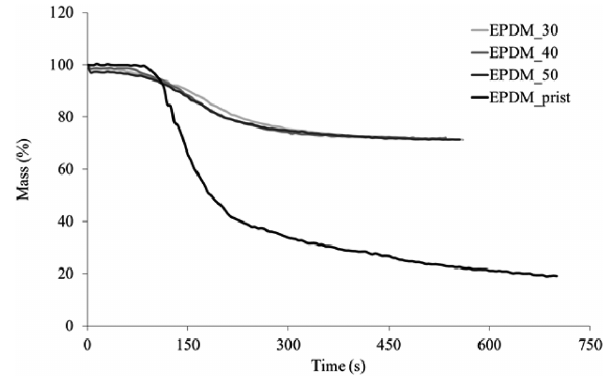
Figure 7: Mass loss curves of samples